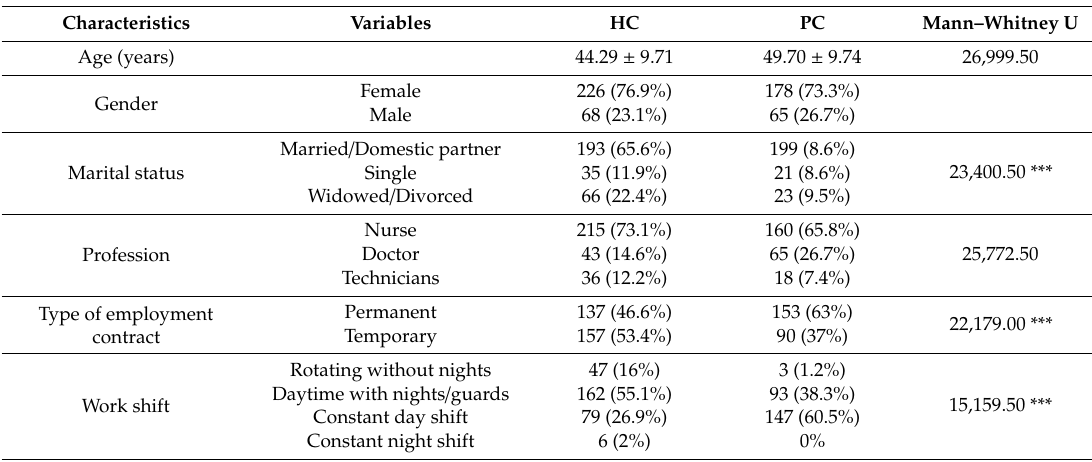
Table 1. Sociodemographic and labor characteristics: primary and hospital